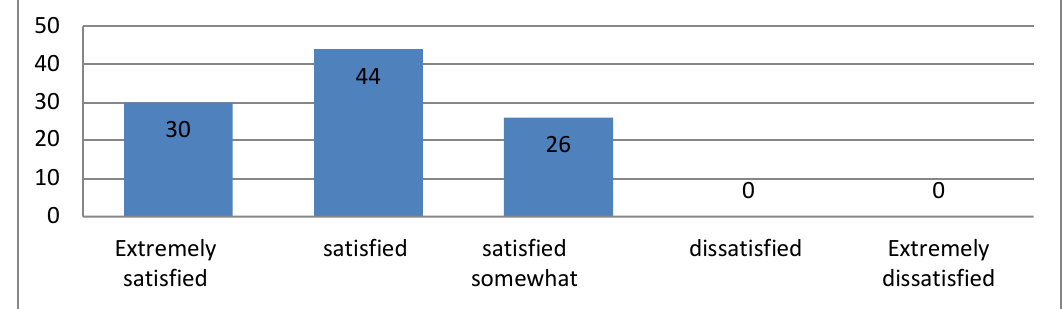
Figure 9: You have the influence in deciding the way your work is